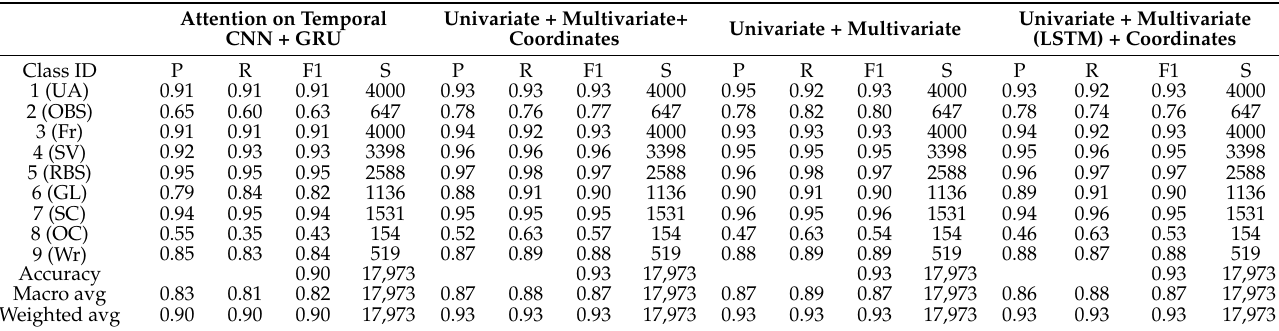
Table 3. Precision, recall and F1 score values for the Attn. On temporal CNN and the univariate + multivariate + pixel